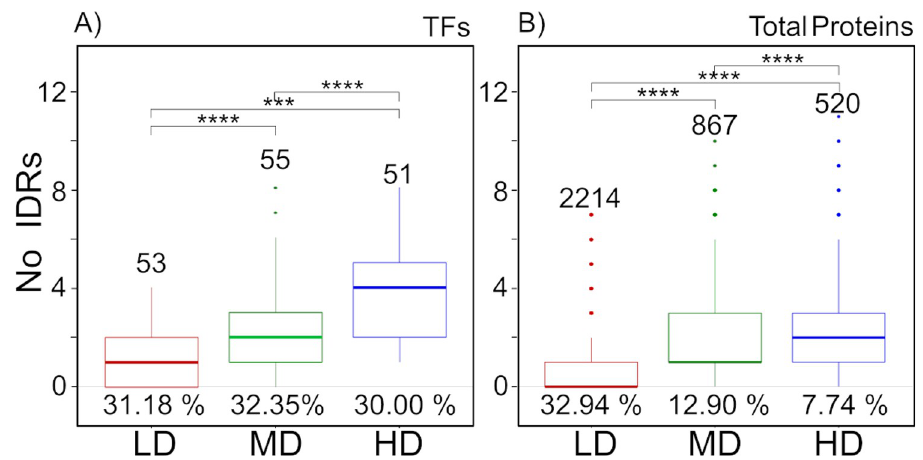
Fig 2. Intrinsically disordered regions (IDRs) in S . cerevisiae proteome. Number of IDRs identified in TFs (A) and total proteins (B) according to MobiDB disorder ratio. LD, MD and HD correspond to low D_ratio (0.1–0.29), medium D_ratio (0.3–0.49), and higher disorder (D_ratio � 0.5), respectively. Ordered TFs or proteins were not included. Asterisks denote differences evaluated with the Wilcoxon test ��� p -value � 0.001 and ���� p - value �